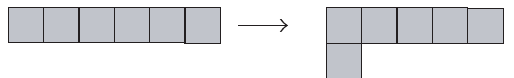
Figure 4.3. Development of a Young diagram by shifting one box from the upper row to the next lower row.